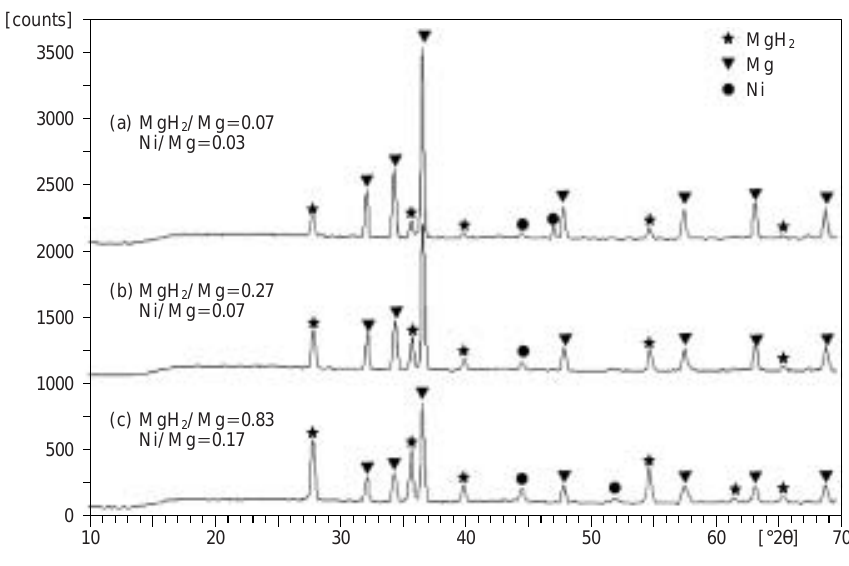
XRD patterns for 44 µ m powder samples of (a) MgH 2 -0.5 at % Ni, (b) MgH 2 -1 at % Ni, and (c) MgH 2 -2 at % Ni processed for 90 minutes. Peak intensity ratios of MgH2/Mg and Ni/Mg for each sample are